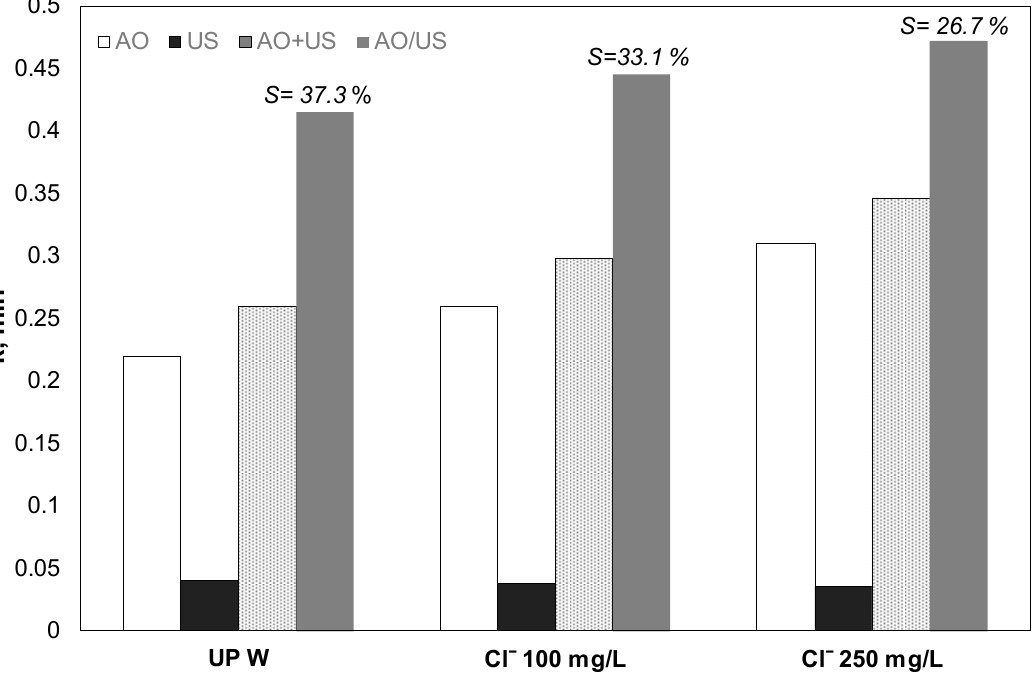
Figure 4. Effect of chlorides on the kinetic constant for the removal of 0.5 mg/L propyl paraben by electrochemical anodic oxidation (AO), ultrasound (US), theoretical sum (AO + US), and combined (AO/US) process. Conditions: [Na 2 SO 4 ] = 0.1 M, 3.75 mA/cm 2 , 36 W/L at 20 kHz and inherent pH.UPW: Ultrapure water.